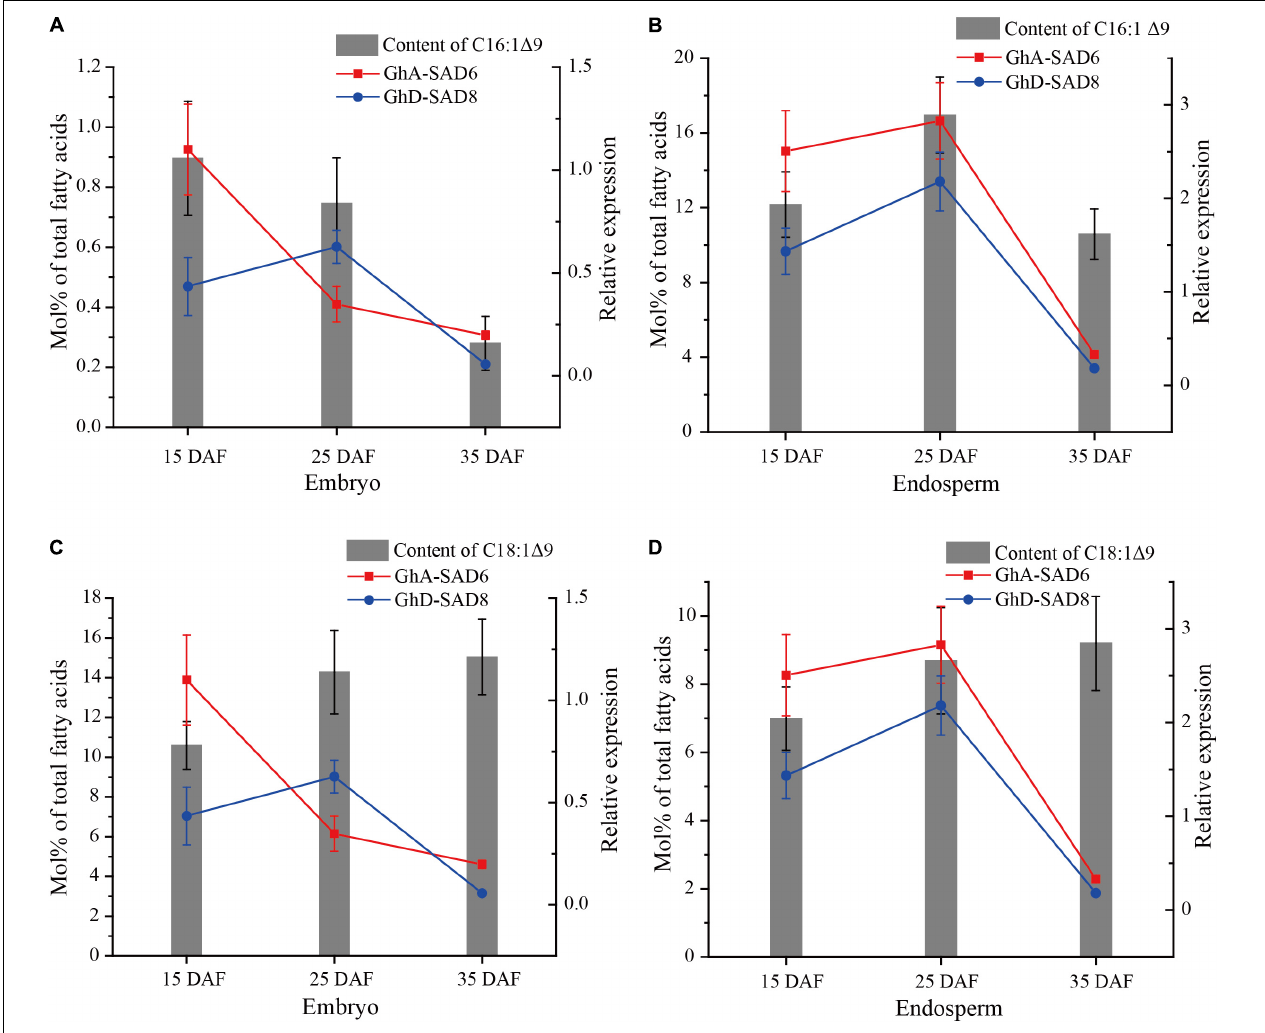
FIGURE 6 | The correlation of the expression of GhA-SAD6 and GhD-SAD8 with molar percentage of C16:1 (cid:49) 9 or C18:1 (cid:49) 9 in developing cotton embryos and endosperms. Columns showed fatty acid content (Mol% of total fatty acids) and lines for relative expression (Red for GhA-SAD6 , blue for GhD-SAD8 ). (A,C) represented the correlation between the fatty acid content (C16:1 (cid:49) 9 or C18:1 (cid:49) 9 ) and relative expression levels of GhA-SAD6 or GhD-SAD8 in developing embryos, respectively. (B,D) were the correlation of C16:1 (cid:49) 9 or C18:1 (cid:49) 9 content with GhA-SAD6 or GhD-SAD8 in developing endosperms, respectively. Six biological replicates were analyzed in each